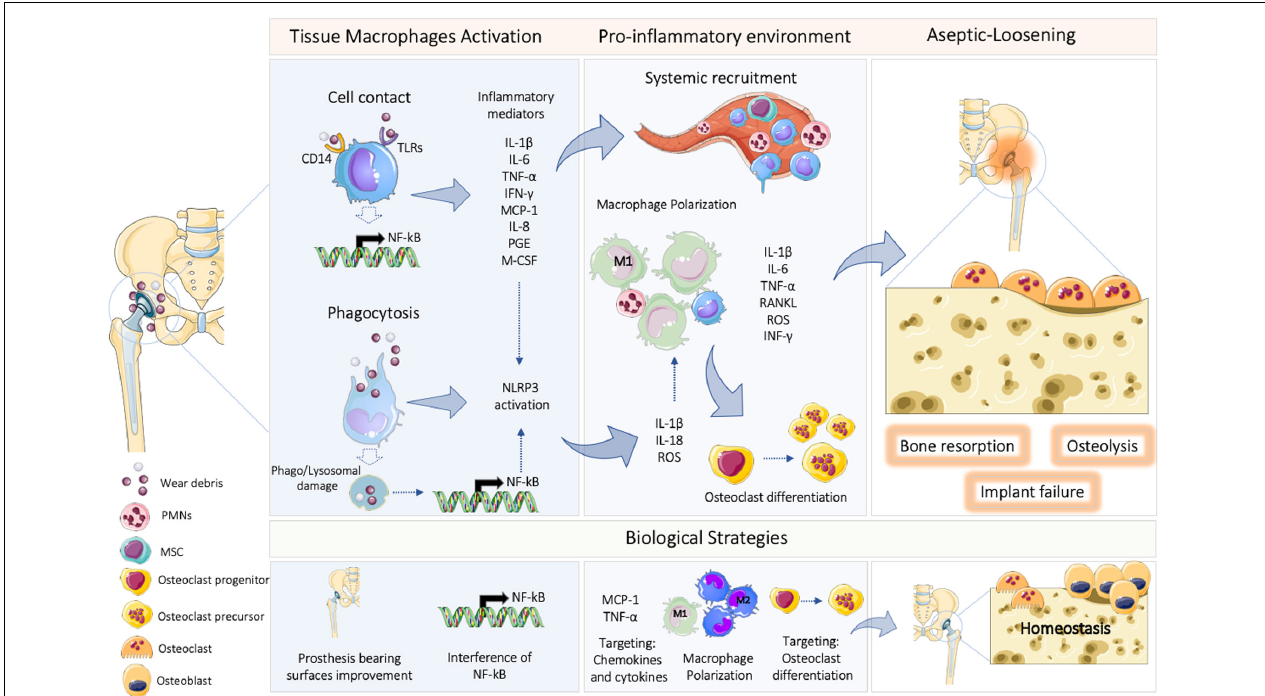
FIGURE 1 | Macrophages response to implant wear particles and biological strategies to prevent aseptic loosening. The macrophages’ reactivity upon activation by wear particles is driven by cell membrane contact through surface receptors, such as CD14 and TLRs, or through the phagocytosis of wear debris. The activation of NF- κ B induces the release of pro-inflammatory cytokines (e.g., TNF- α , IL-1, IL-6, and PGE-2), growth factors (M-CSF), pro-osteoclastic factors (RANKL), and chemokines (e.g., IL-8, MIP-1 α , and MCP-1), leading to the systemic recruitment of more macrophages and osteoclast precursors, thus promoting inflammation and osteolysis. This figure also summarizes some proposed biological strategies to prevent and treat aseptic loosening. TLR, Toll-like receptor; PMNs, polymorphonuclear cells; IL, interleukin; NF- κ B, nuclear factor kappa B; NLRP3, NOD-, LRR-, and pyrin domain-containing protein 3; TNF, tumor necrosis factor; RANKL, receptor activator of nuclear factor kappa B ligand; ROS, reactive oxygen species; MSC, mesenchymal stem cell; MCP-1, monocyte chemoattractant protein-1; CD, cluster of differentiation; M-CSF, macrophage colony stimulating factor 1; PGE, prostaglandin E; IFN,